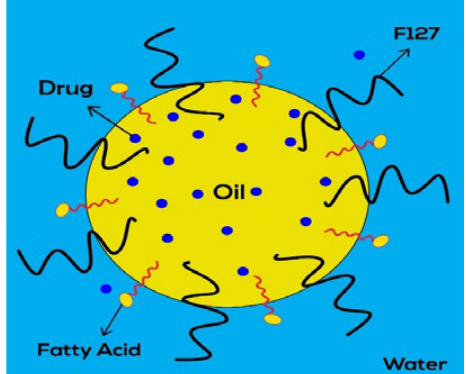
Fig. 1. molecular structure of Tocopherol